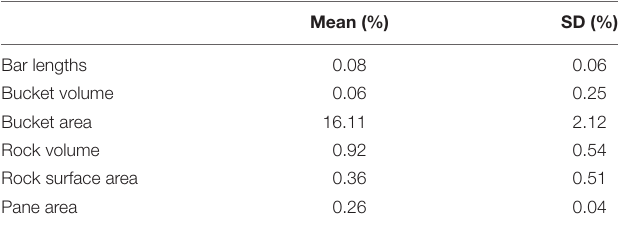
TABLE 5 | Effects of the distance to scale bar on the standard deviation of marker coordinates for the 3 axes. SD X (mm) SD Y (mm) SD Z (mm) Distance to scale bar (m) 1.2 ∗∗∗ Variance explained 54% 55% 90% Results show the estimate of slope and the p-value of the t-test (“ ∗∗∗ ” if p < 0.001). SD, Standard deviation.